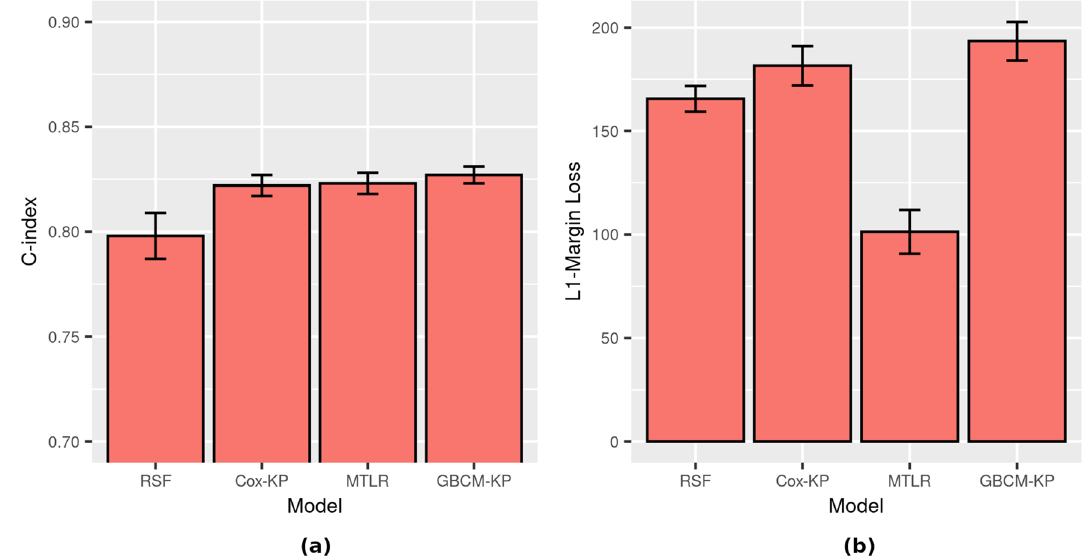
Figure 3. Survival prediction performance on dataset D1 (N = 75,063) for using age and sex as covariates, to predict time until hospital discharge: ( a ) C-index, and ( b ) L1-Margin loss. All four models in this experiment were calibrated ( p -value ≥ 0.05 ). Recall that large values are good for C-index, while small values are good for L1-Margin